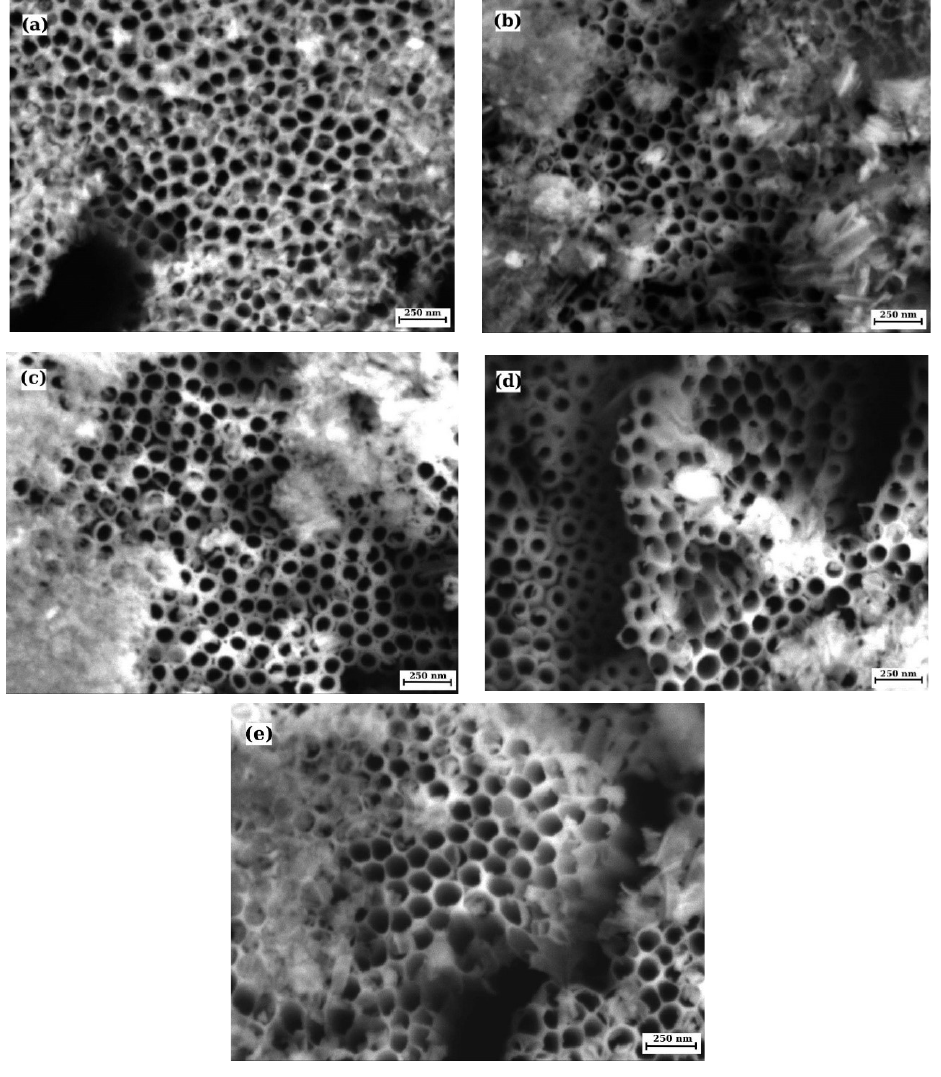
Figure 5. SEM images of the anodized surface of Ti6Al4V at di ff erent times, 10 min ( a ), 20 min ( b ), 30 min ( c ), 40 min ( d ), and 50 min ( e